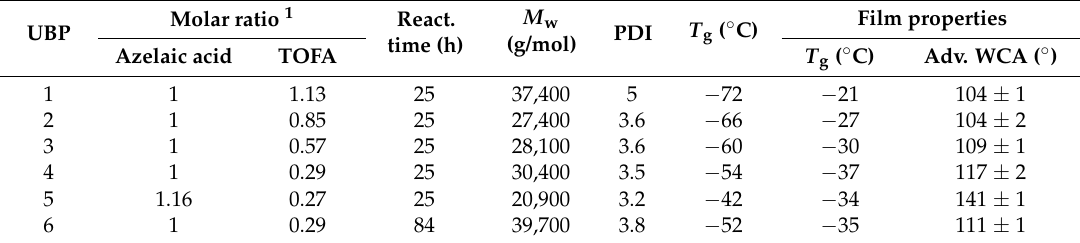
Table 1. Molar masses and glass transition temperatures of the pristine UBPs as well as glass transition temperatures and WCA determined for the coated and crosslinked UBPs. M w Molar ratio 1 React. UBP PDI T g ( ◦ (g/mol) time (h)